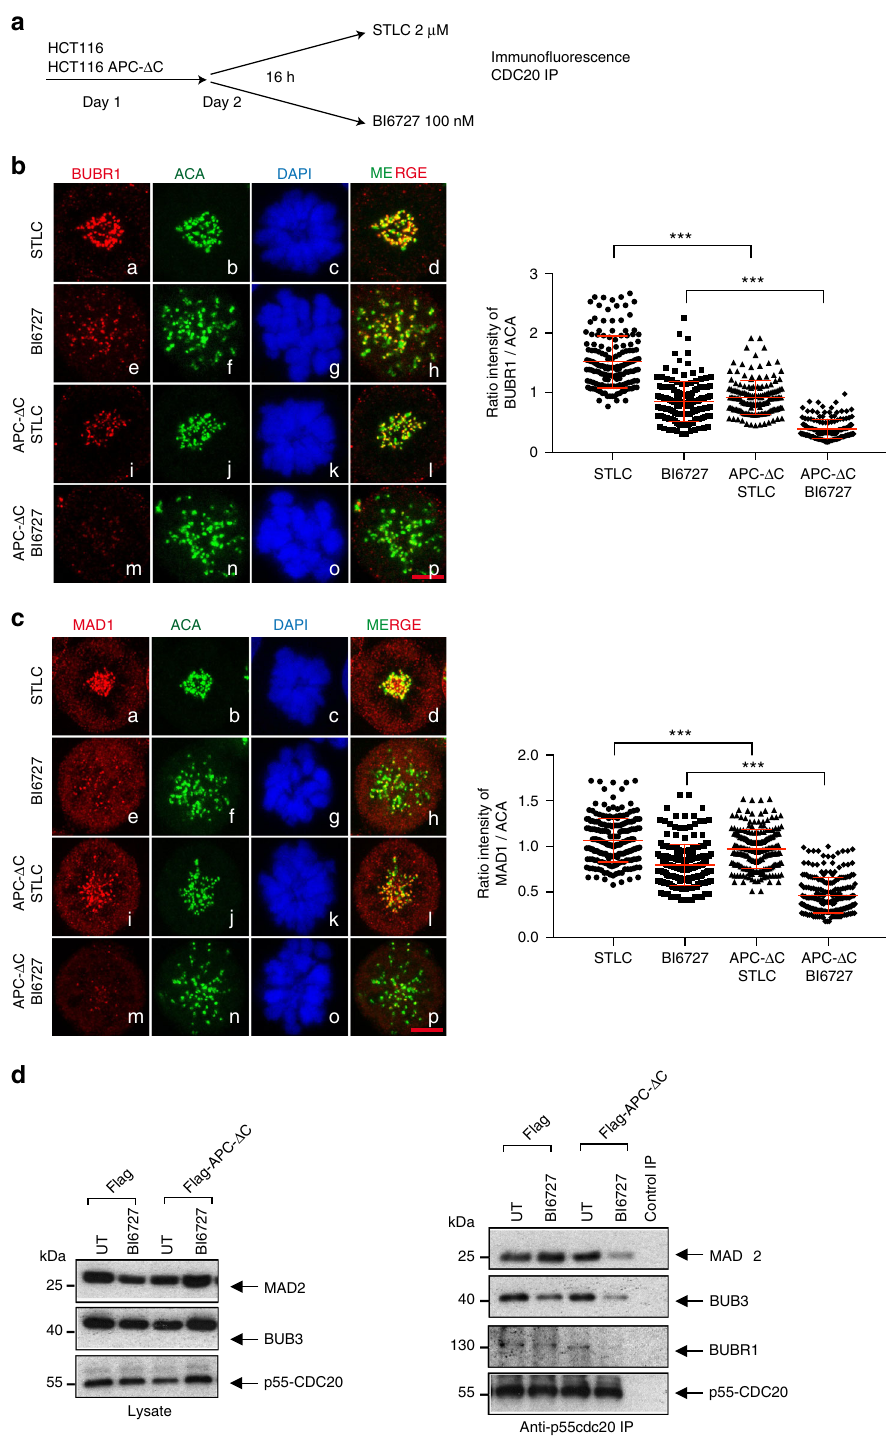
Fig. 7 Inhibition of PLK1 in APC- Δ C-expressing HCT116 cells reduces the recruitment of BUBR1, MAD1 to kinetochore and decreases the mitotic checkpoint complex association. a Scheme of the experimental procedure. APC- Δ C-expressing and control HCT116 cells were seeded on day 1, treated on day 2 either with 2 µ M STLC or 100 nM BI6727 for 16 h and harvested on day 3. The kinetochore recruitment of the checkpoint proteins ( b ) BUBR1 and ( c ) MAD1 was monitored. After treatment, cells were fi xed and stained with the indicated antibodies. Scale bar, 5 µ m. The kinetochore intensities of BUBR1 and MAD1 staining in the different treatment groups were quanti fi ed. The intensities were normalized to ACA. Values were calculated from at least 50 cells per treatment (means ± s.d., n = 3, for each treatment). *** P < 0.001, Student ’ s t -test, unpaired and two-tailed. d Lysates (left panel) and immunoprecipitation of CCD20 from asynchronous and BI6727 (100 nM)-treated HCT-116 and APC- Δ C-expressing HCT116 cells were analyzed (right panel). CCD20- interacting proteins from IP were analyzed using western blot for MAD2, BUB3, BUBR1, and